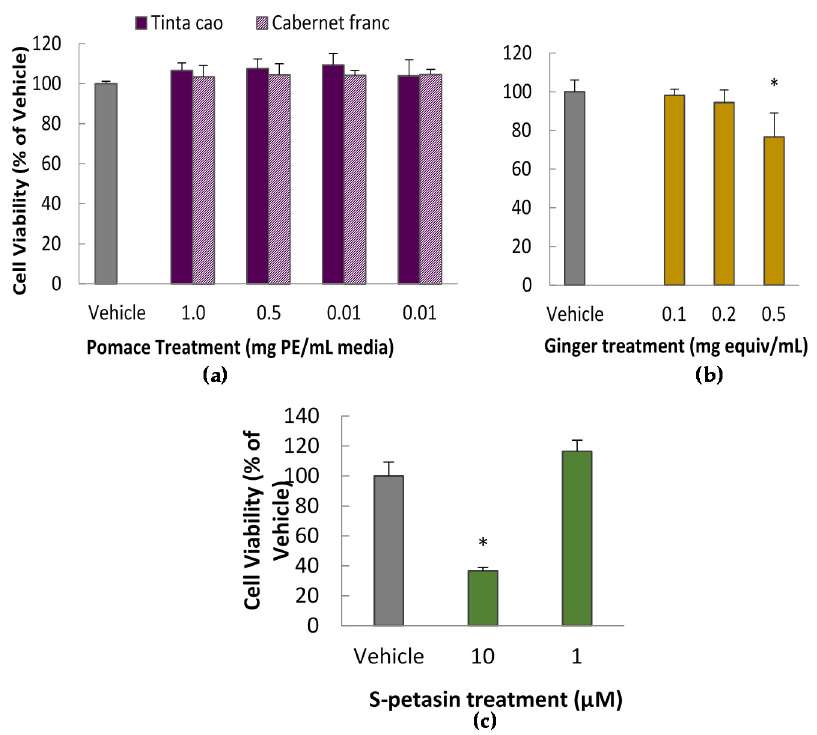
Figure 1. CA77 cell viability after 24-h treatment with extracts: ( a ) Tinta cao and Cabernet franc grape pomace extract treatments ( n = 8), ( b ) Ginger root extract treatments ( n = 8), and ( c ) purified S -petasin treatments ( n = 4). PE = pomace equivalents. Results obtained via the Methylene Blue Cytotoxicity Assay. All treatments contain 0.1% DMSO (dimethyl sulfoxide), including vehicle. * Indicates a value statistically different from the vehicle ( P < 0.05).